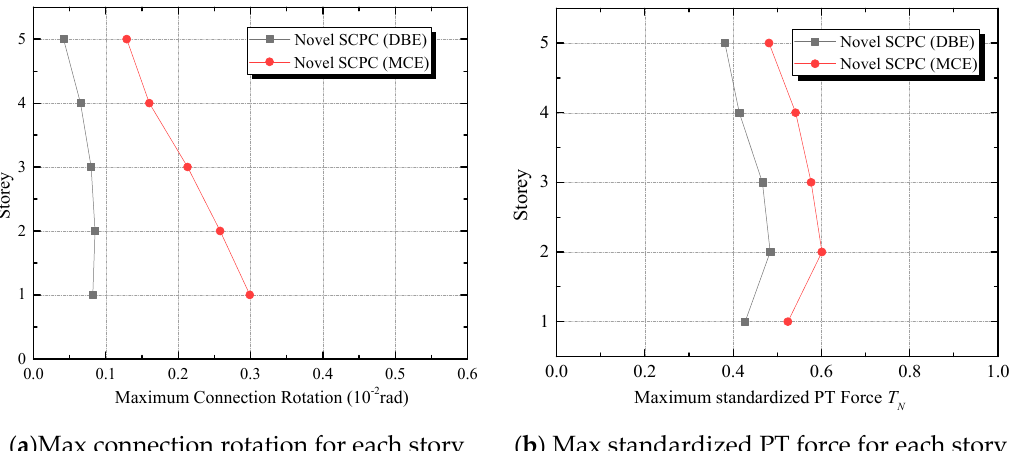
Figure 17. Maximum connection rotation and standardized PT force for each story.